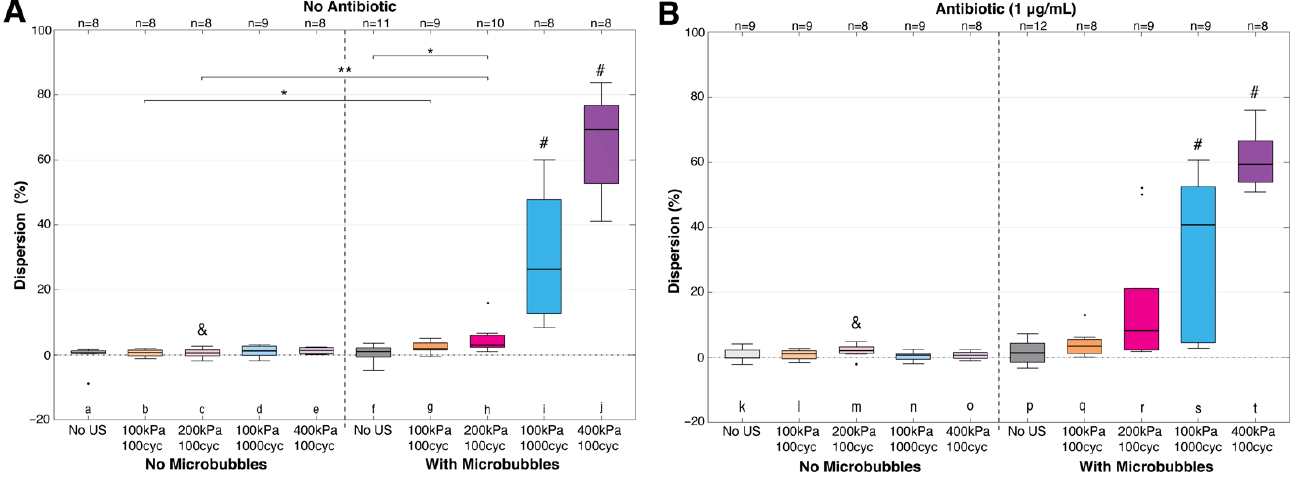
Figure 7. Dispersion of bacteria within biofilms (Equation (3); dispersion (%)). Key statistically significant differences are indicated with * p < 0.05. or ** p < 0.01. Black circles denote outliers. Statistical significance from all other groups within the same graph are marked by a (#). If adding an antibiotic, ( B ) was different from the same treatment without ( A ), which is denoted with (&) for p < 0.05. cyc = cycles; US = ultrasound. See Supplementary Table S4 for all statistical comparisons.